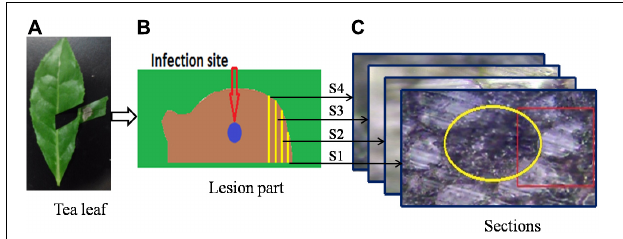
FIGURE 1 | A schematic of the sample preparation process: (A) infected tea leaf, (B) enlargement of infected area, and (C) bright field microscopy images of